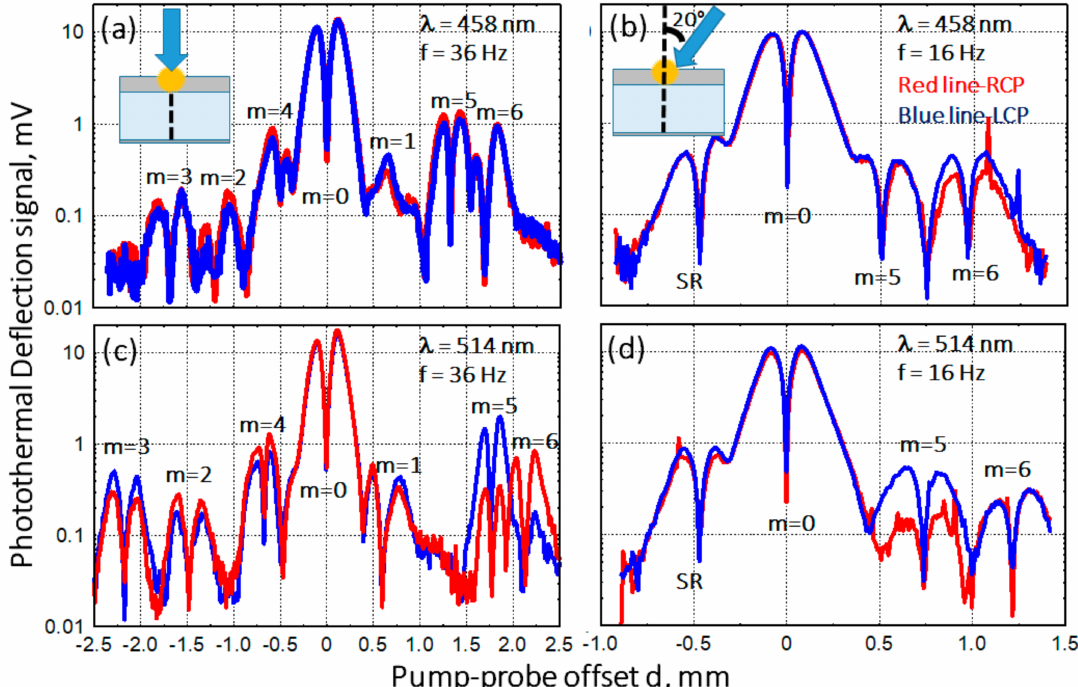
Figure 3. Amplitude of the photothermal deflection vs. pump–probe offset on Ag-SNSA sam- ple excited with an Ar pump beam under different conditions: ( a ) normal incidence, wavelength λ = 458 nm; modulation frequency 36 Hz; ( b ) oblique incidence at 20 deg, wavelength λ = 458 nm; modulation frequency 16 Hz; ( c ) normal incidence, wavelength λ = 514 nm; modulation frequency 36 Hz; ( d ) oblique incidence at 20 deg, wavelength λ = 514 nm; modulation frequency 16 Hz. Red and blue lines indicate RCP and LCP responses,